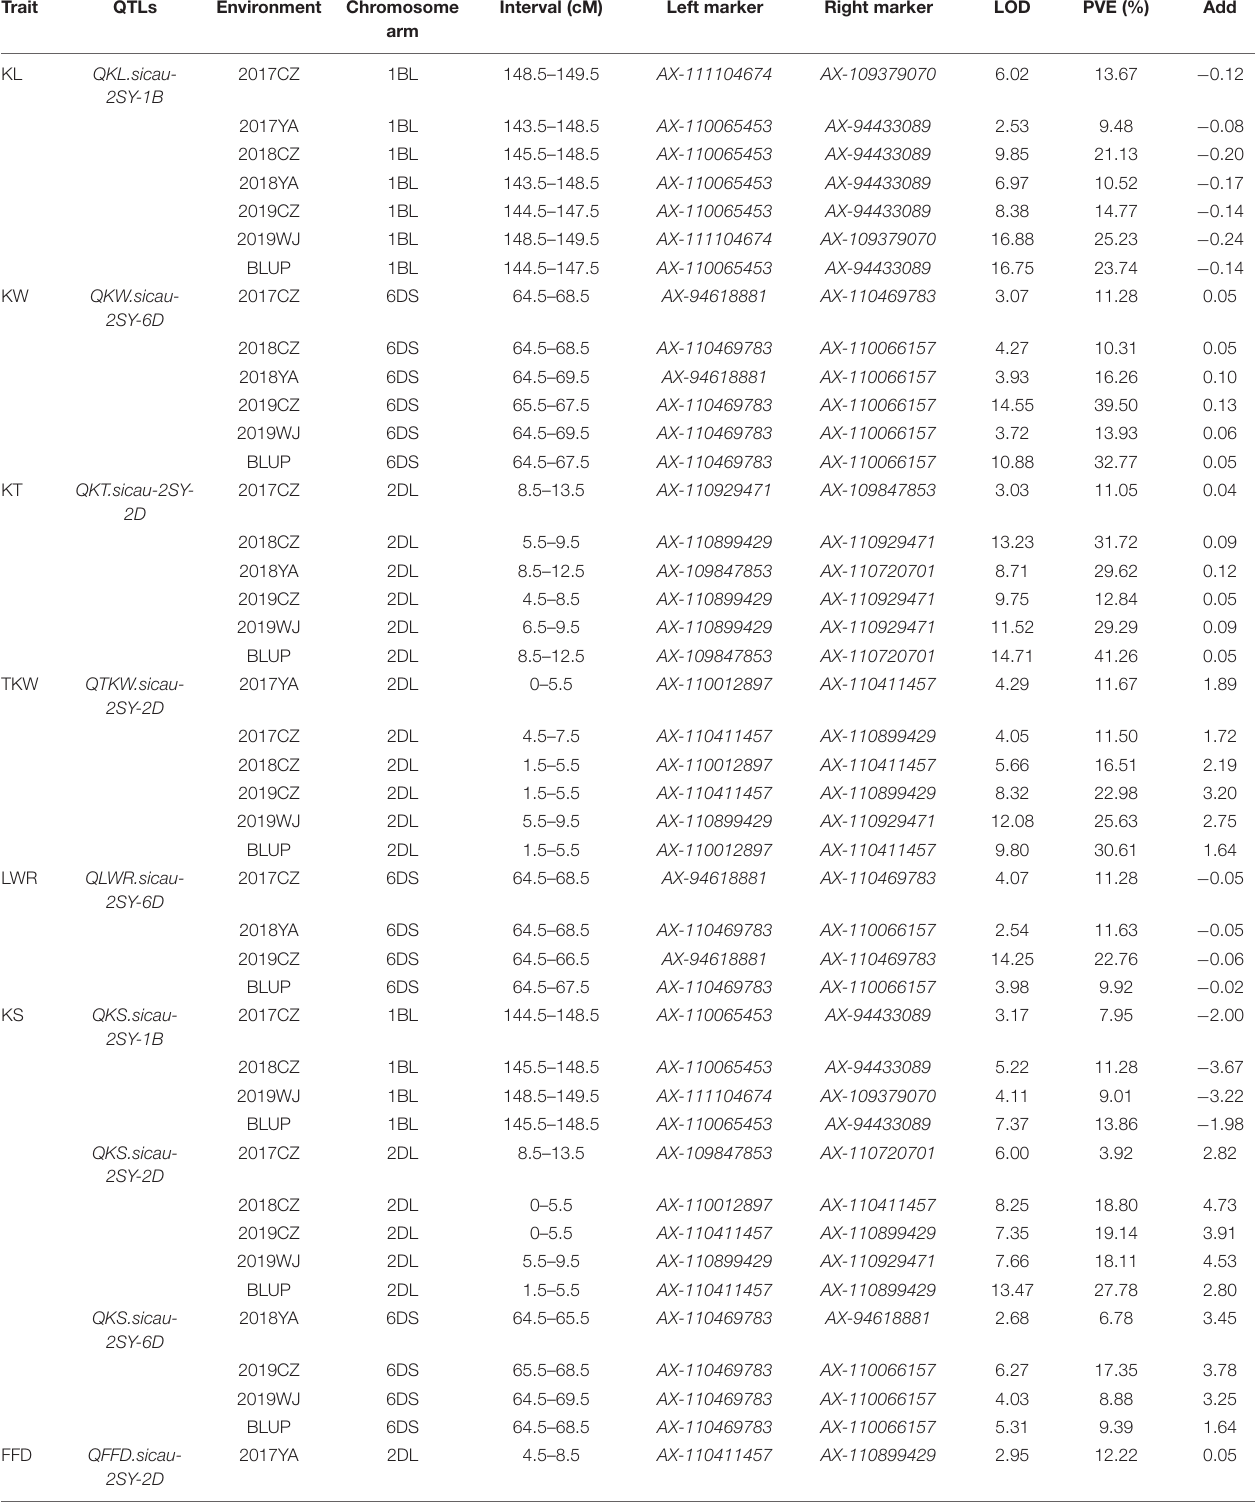
TABLE 2 | Quantitative trait loci (QTLs) for kernel traits and plant height (PH) and anthesis date (AD) detected in more than three environments in the “20828” × “SY95-71” population. Trait QTLs Environment Chromosome